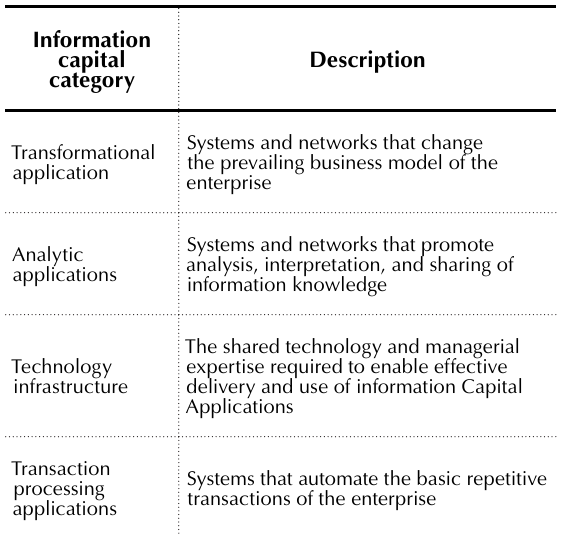
Table 1. Information capital category Source: Kaplan and Norton